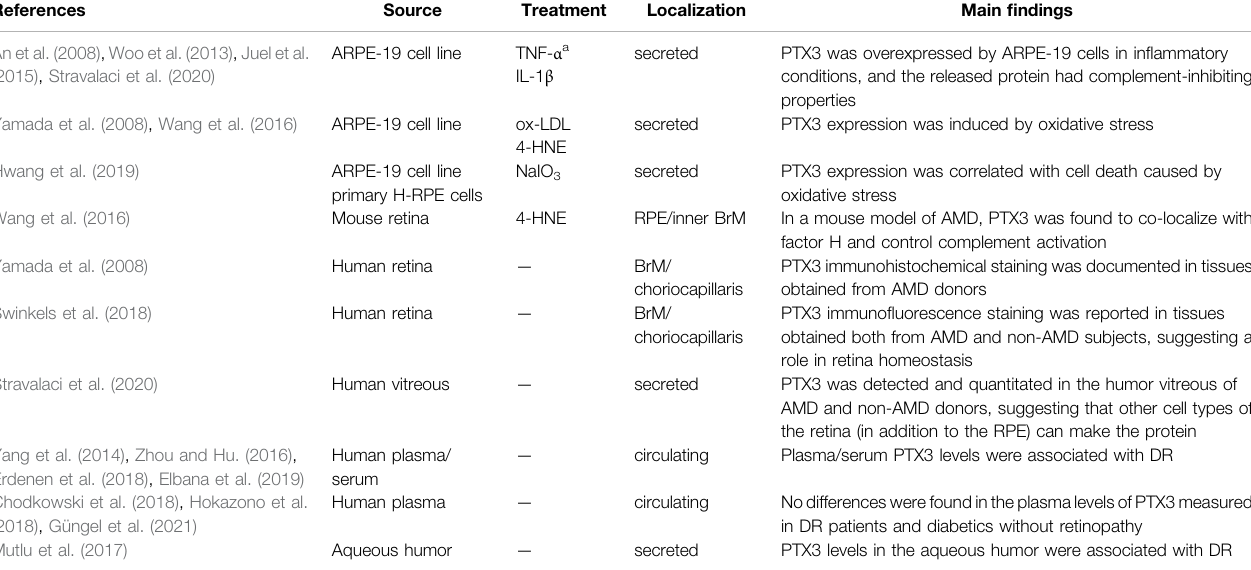
TABLE 1 | Studies describing expression and localization of PTX3 in AMD and